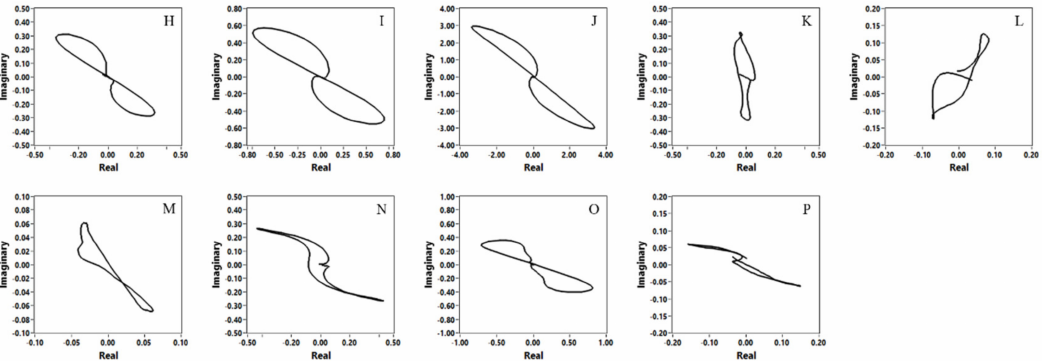
Figure 10. Lissajous curves from the front bobbin coils for the specimen with multisite flaws (50 kHz AC).